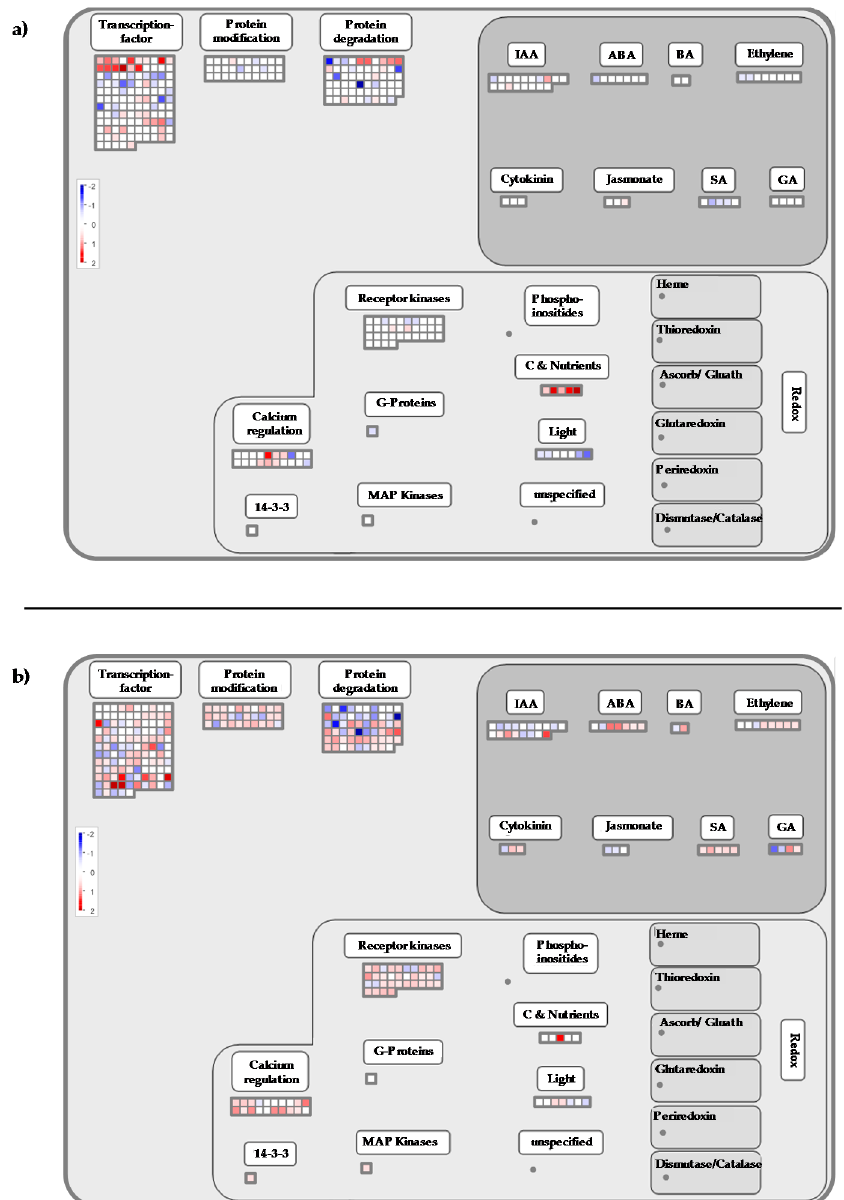
Figure 3. Mapman visualization of the regulation process pathway modulation at ( a ) 8 h and ( b ) 2 h PS.